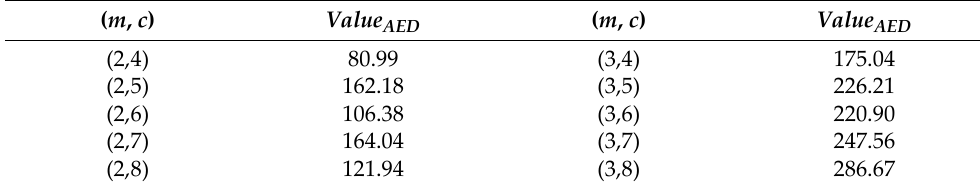
Table 8. The Value AED under different ( m , c )